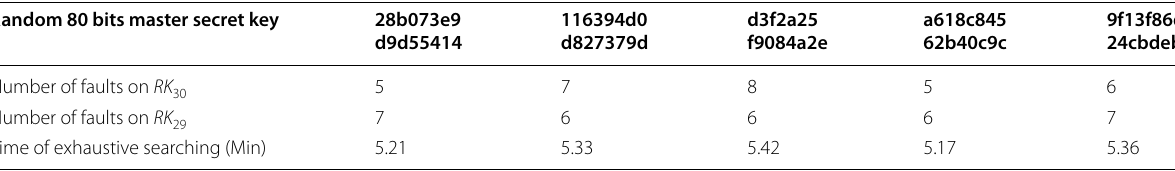
Table 7 Five typical examples Random 80 bits master secret key